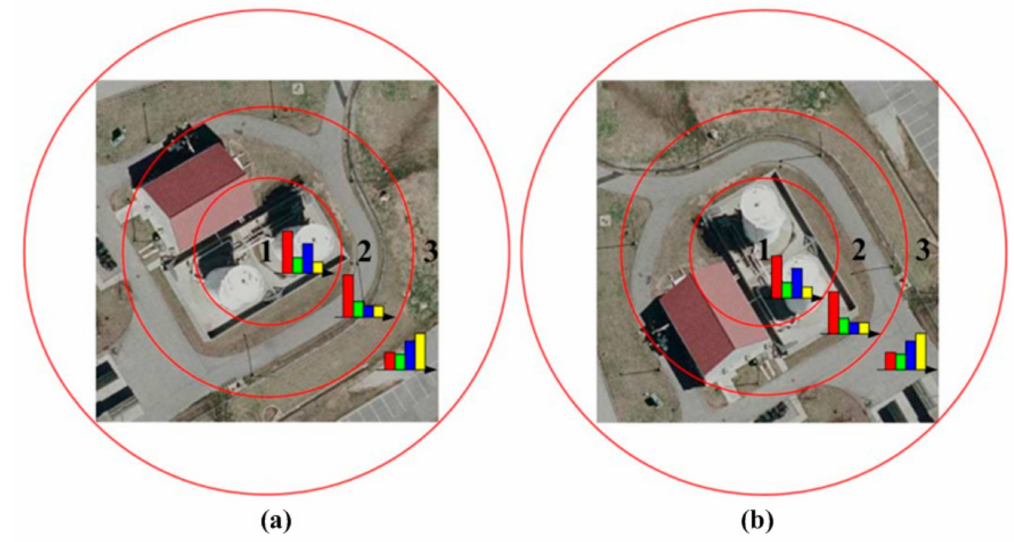
Figure 1. Example of spatial partition of rotated remote sensing images using a concentric circle-based partition strategy; ( a ) Original image, and ( b ) rotated